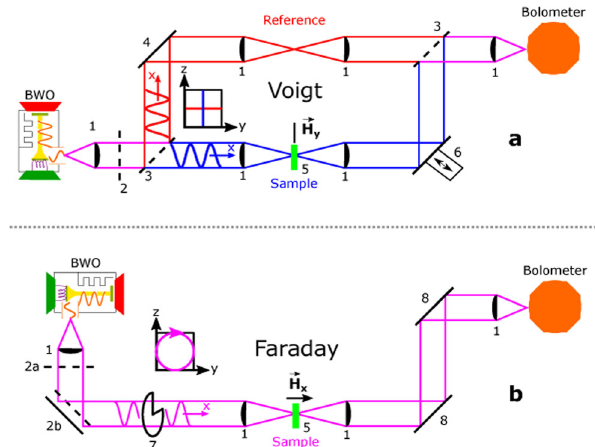
Fig. 1 Experimental setup. Mach-Zehnder interferometer using linearly polarized light beam in Voigt ( a magnetic fi eld perpendicular to light propagation), and transmission measurement setup with circularly polarized beam in Faraday ( b magnetic fi eld parallel to light propagation) geometry. The signal is detected by a bolometer operating at T = 4 K temperature, backward-wave oscillator (BWO) serves as light source, and optical elements are marked by numbers (1 polytetra fl uoroethylene focusing lens, 2, 2a linear polarizer, 2b circular polarizer, 3 beam-splitting polarizer, 4 standing mirror, 5 sample in magnetic fi eld, 6 moving mirror, 7 circularly polarized light, 8. standing mirror). Insets show the polarization state of the incoming light (linear for Voigt and circular for Faraday